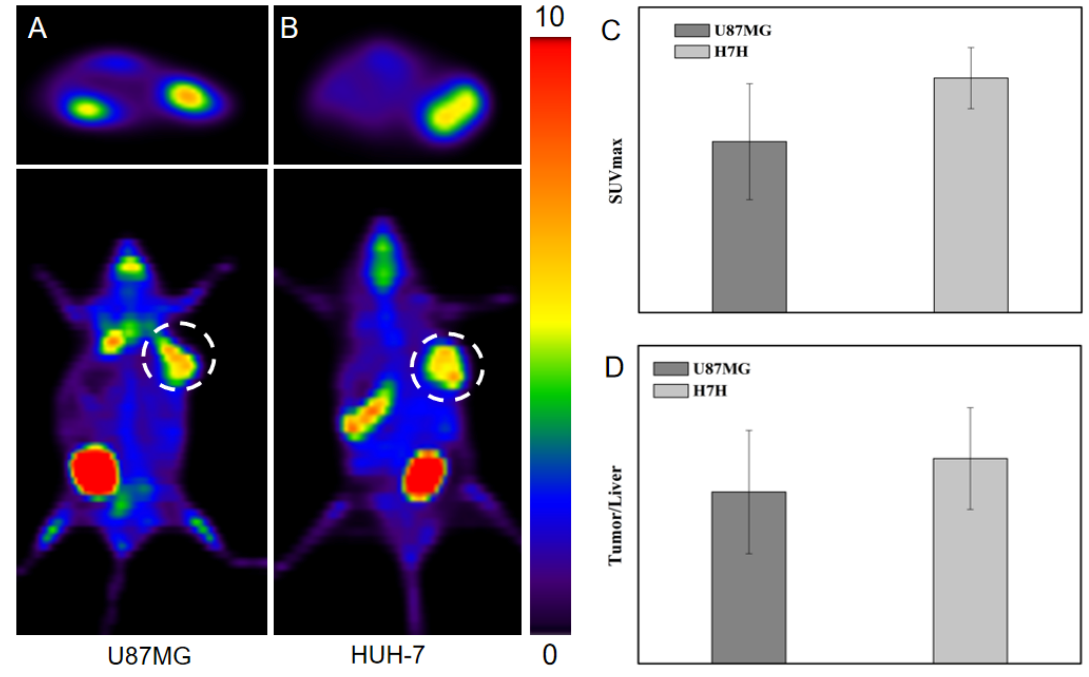
Figure 4. FDG PET of mice models of ( A ) U87MG and ( B ) HUH-7, and ( C ) the corresponding quantitative analysis, such as SUV max and ( D ) tumor to liver ratio of SUV max . The white dotted circles marked the FAP-positive or FAP-negative tumors.